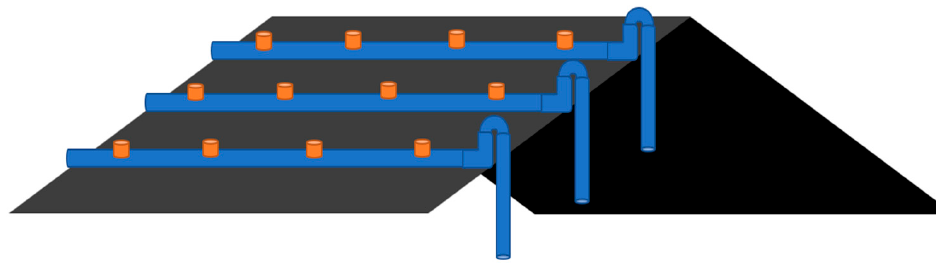
Figure 11. Details of the pipeline network on a sloped roof.